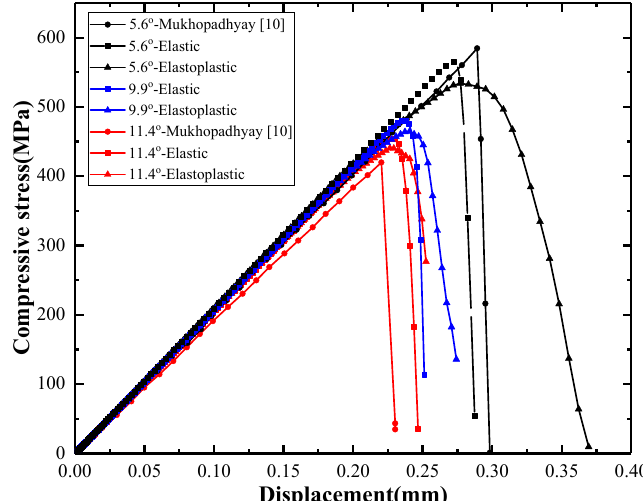
Figure 12. Predicted compressive stress versus displacement, obtained using three different